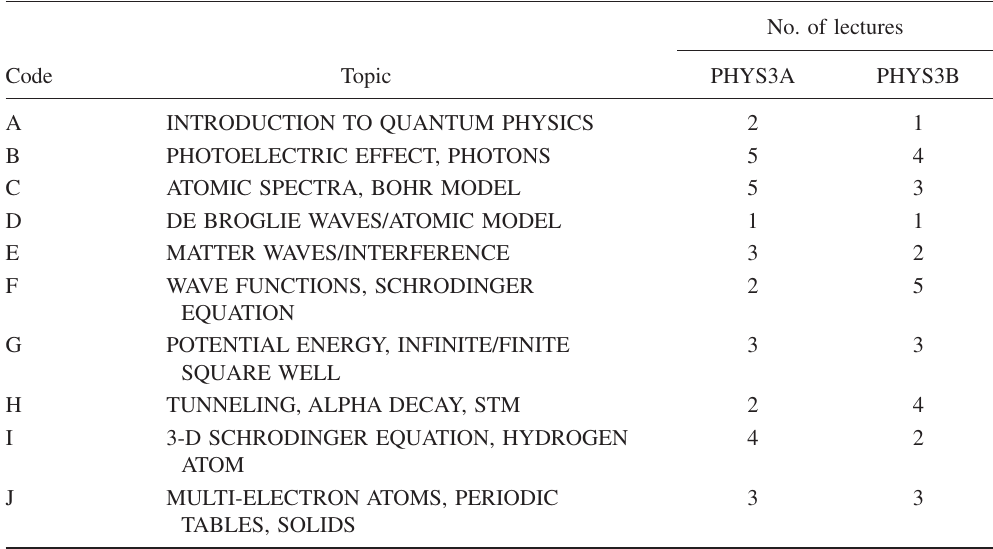
TABLE I. Progression of topics and number of lectures devoted to each topic from the quantum physics portion of both modern physics